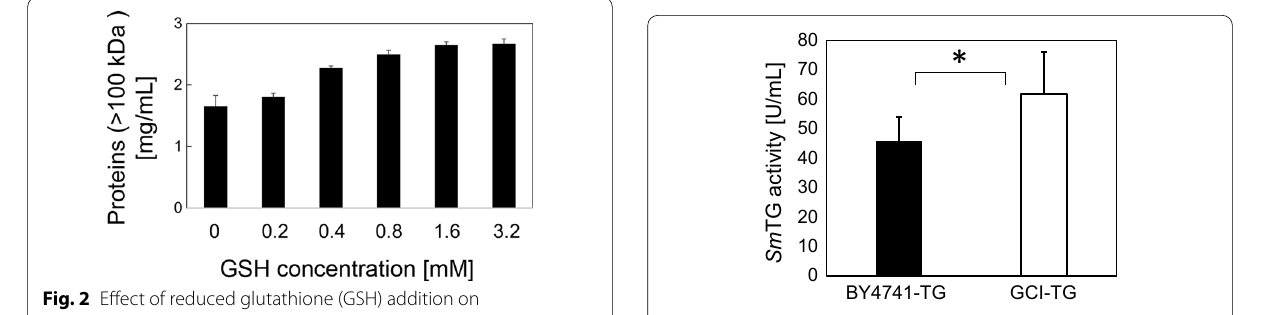
Sm TG extracted from the ×